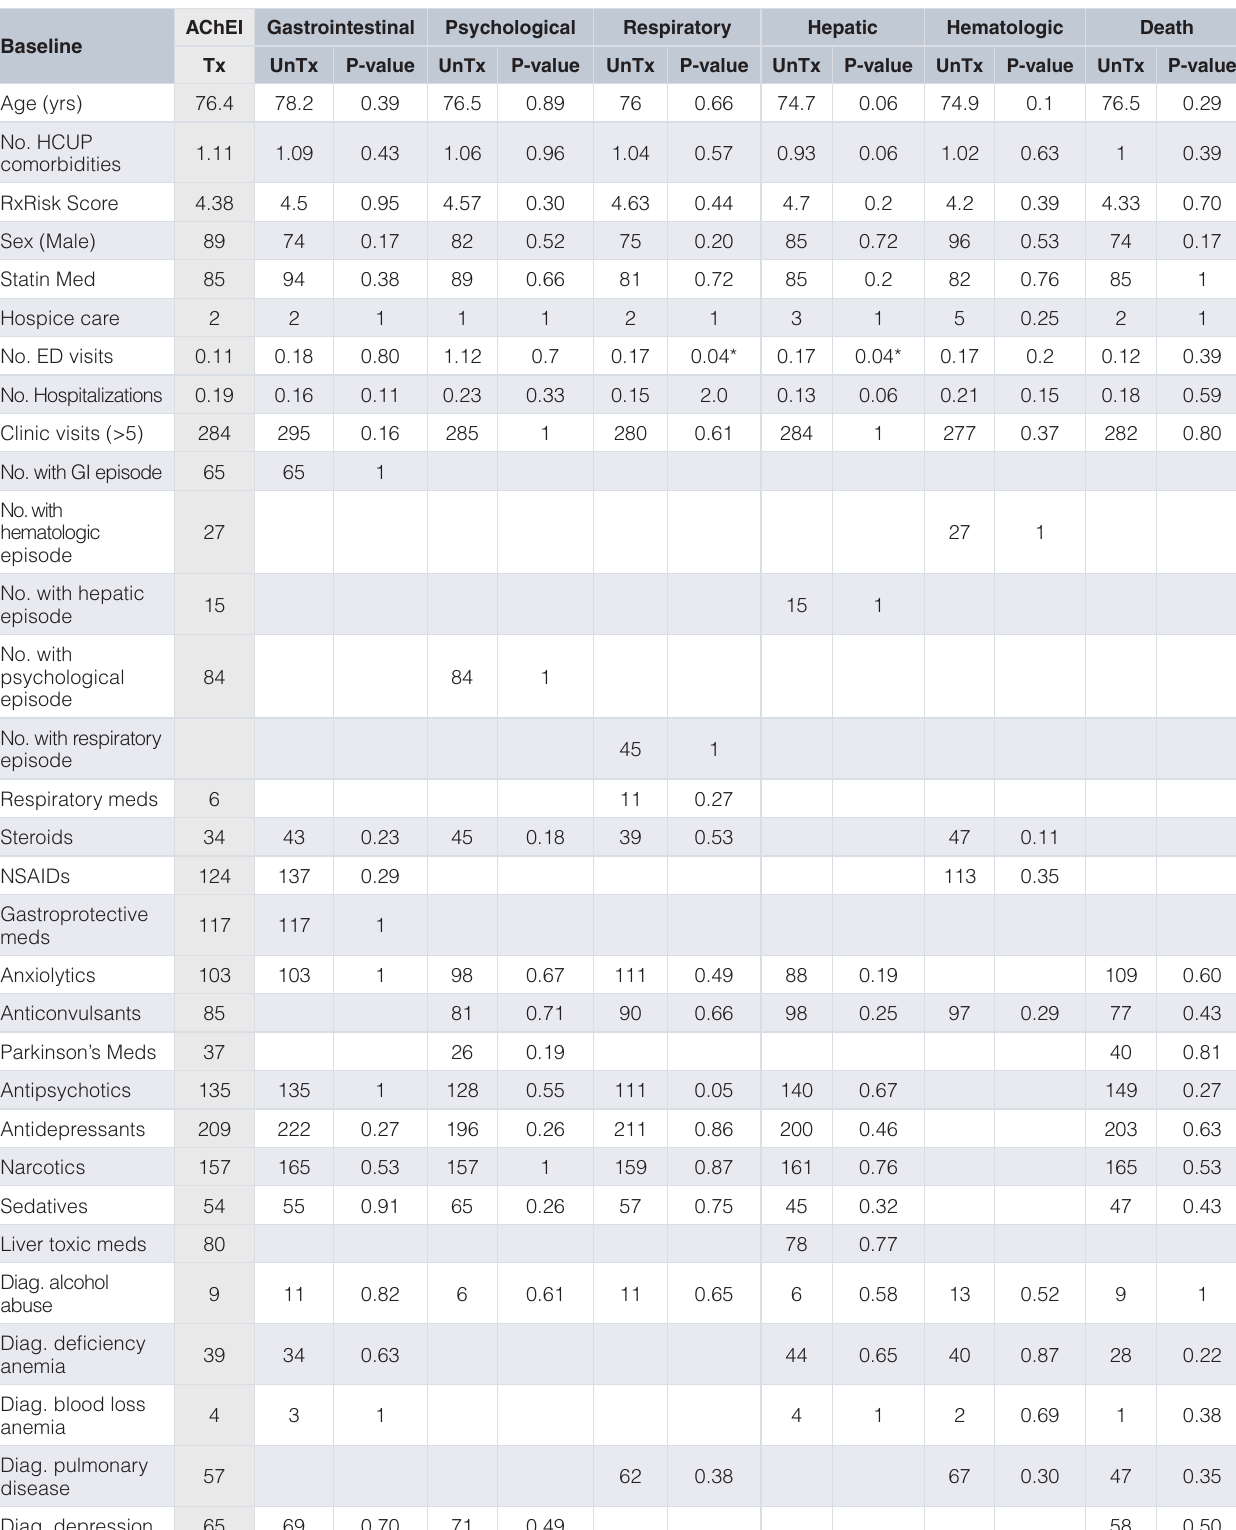
Table 3. Baseline comparisons for all variables included in each matched cohort analysis.